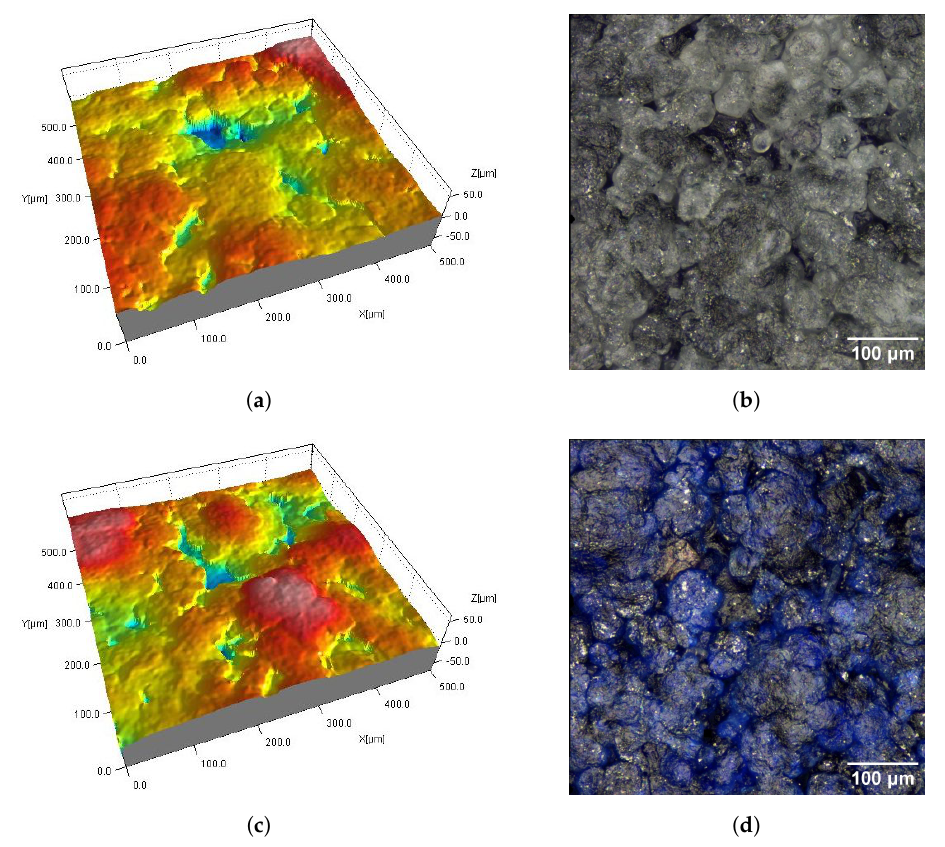
Figure 8. Surfaces of MJF samples after mechanical smoothing DM_PSC ( a , b ) and DM_PSC_Col ( c , d ): fragments 0.5 mm × 0.5 mm of 3D maps ( a , c ) and corresponding 2D views ( b , d